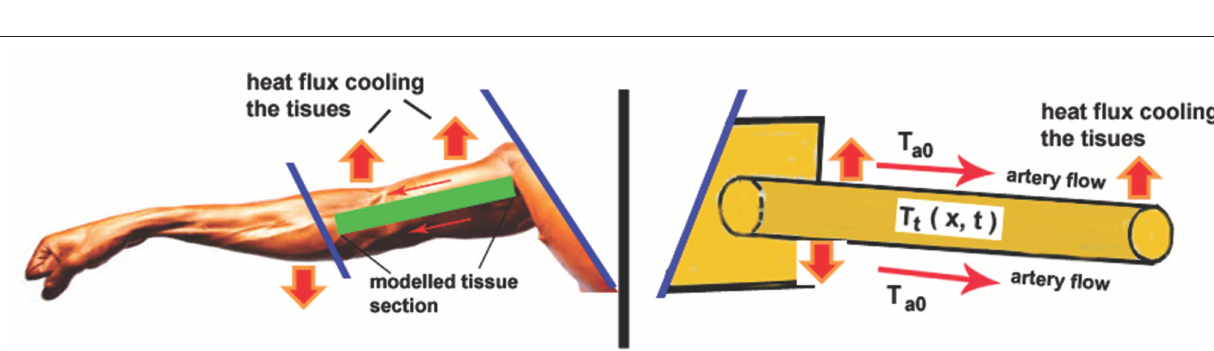
FIGURE 4 | Forearm-Fin mechanical analogy of the logical construction used in the Pennes model. Present author conceived analogy and interpretations: see the explanations in the text.